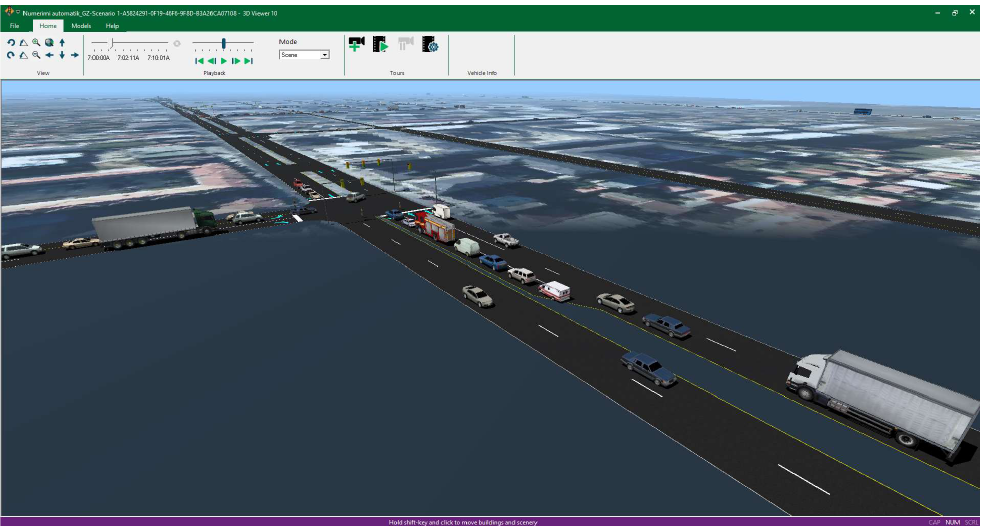
Figure 11. Road traffic simulation in “Sim” model.